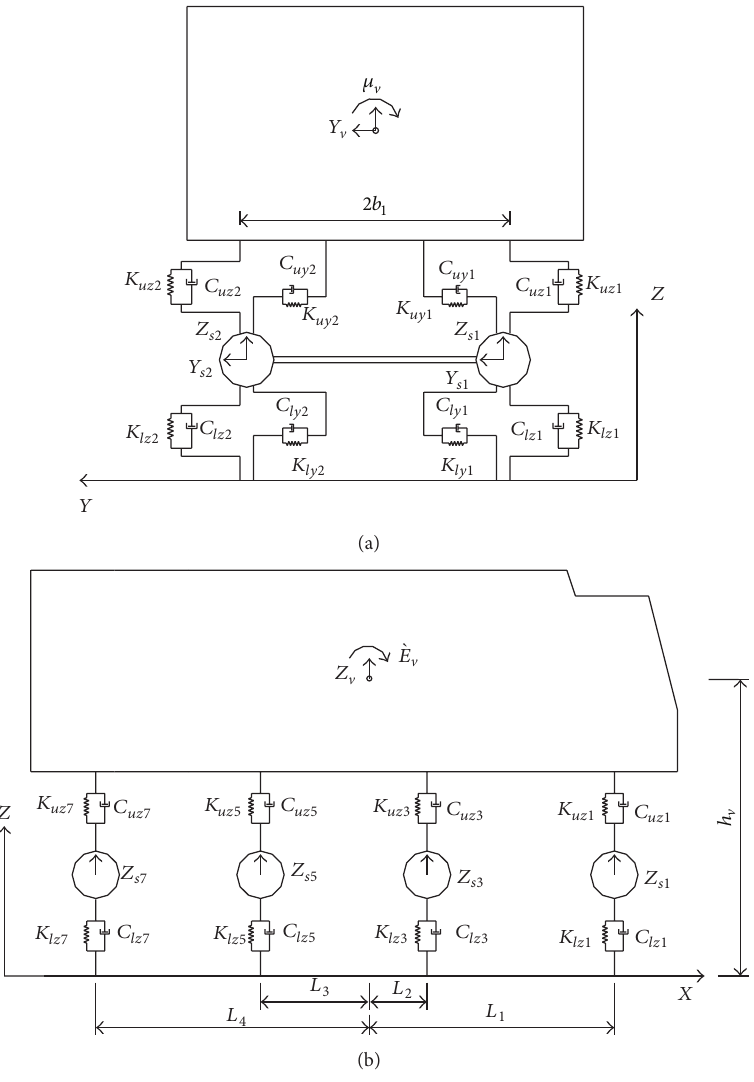
Table 3: Major parameters of vehicles used in case study. Parameter